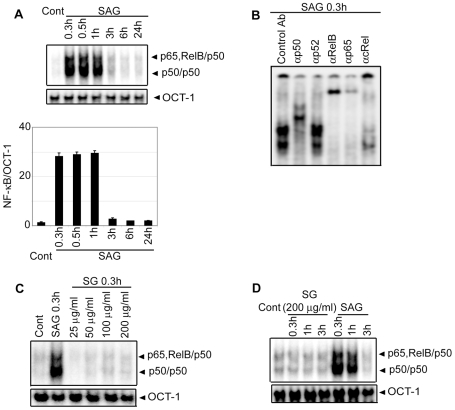
Stimulation with SAG increases nuclear NF-κB DNA binding activity in BMDCs.BMDCs were treated with SAG (20 µg/ml) or specified concentrations of sodium gluconate (SG) for indicated times or left untreated. (A, C-D) DNA binding activity of nuclear NF-κB to H2K-specific oligonucleotide probe was measured via EMSA. The OCT-1 DNA binding was used as an internal control. Densitometric analysis represents the ratio of intensity of NF-κB to OCT-1 binding per unit area and is represented as arbitrary units. (B) Binding of different NF-κB complexes to H2K-DNA probe was determined by supershift EMSA using rabbit IgG (Control Ab) or Abs specific for different NF-κB subunits. For this and all other figures, control (Cont) lane represents uninfected DCs without SAG stimulation. Data are representative of three independent experiments. Error bars indicate mean ± SD.